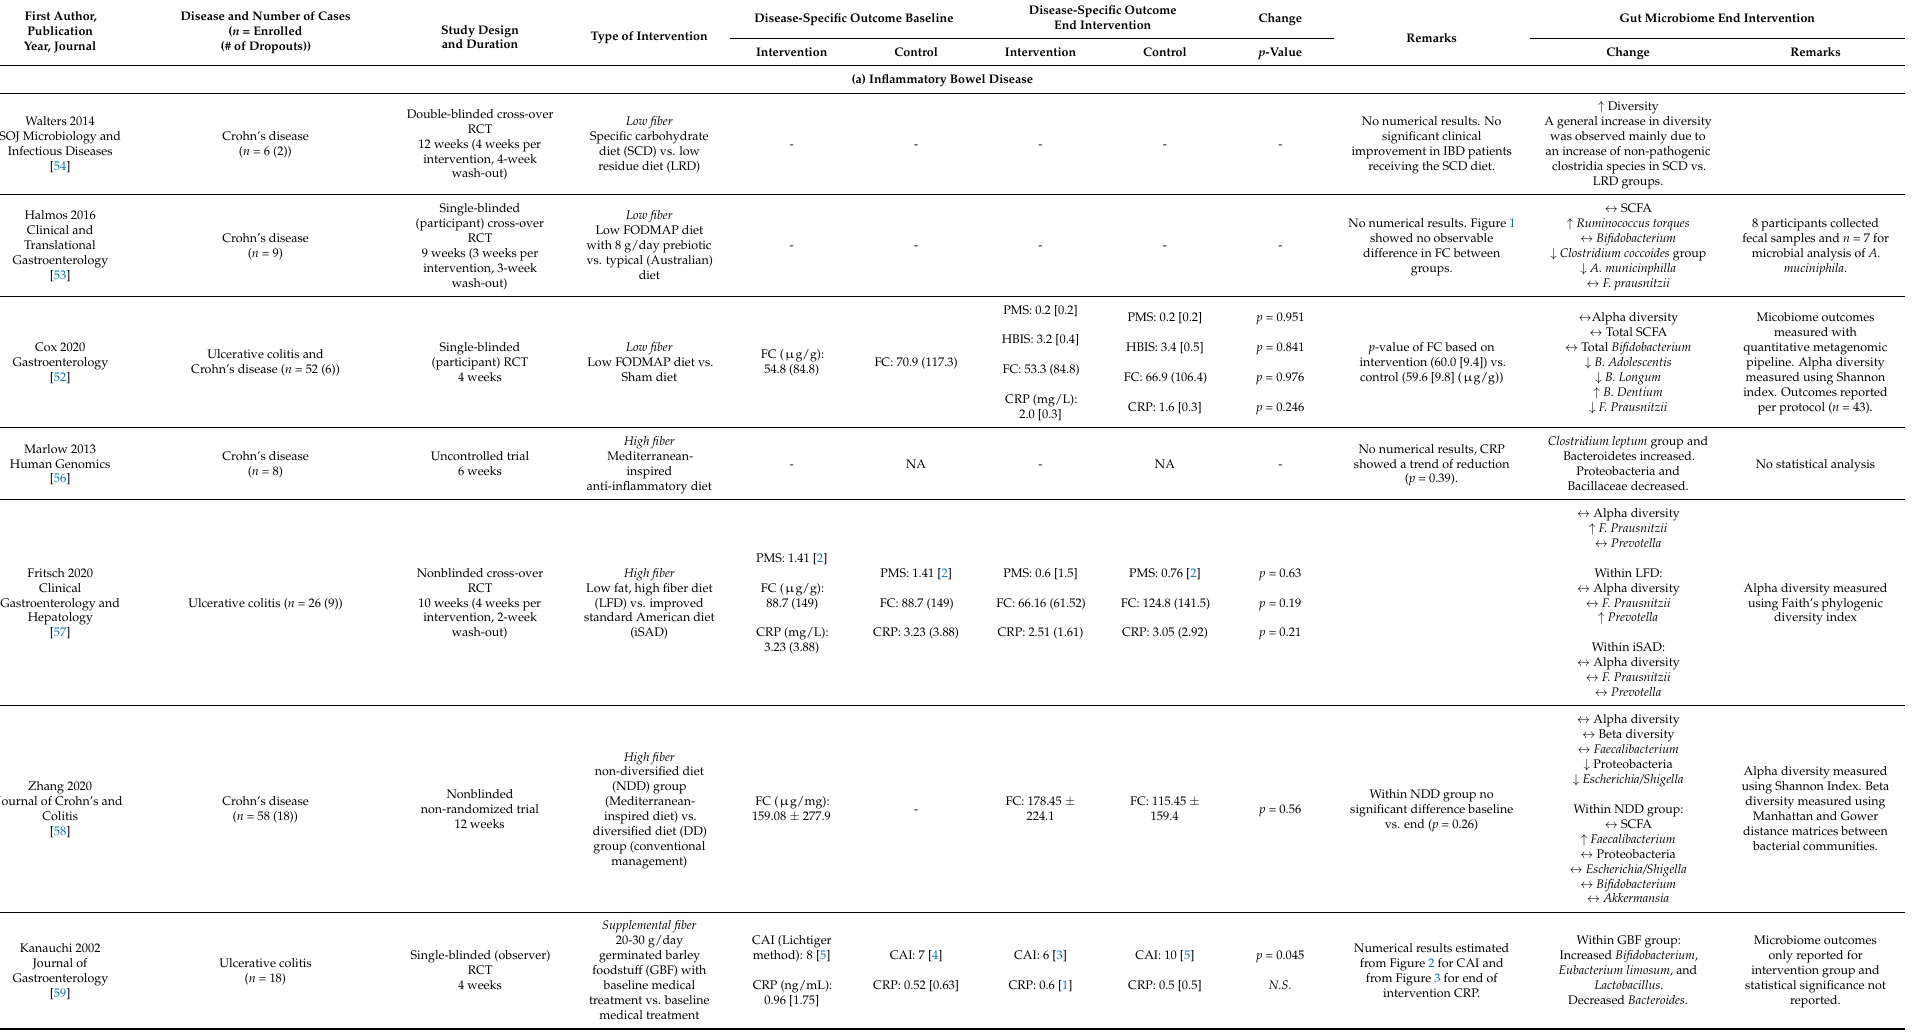
Table 1. Characteristics of the included studies and overview of outcomes in patients with: (a) inflammatory bowel disease, (b) rheumatoid arthritis, (c) cardiovascular disease, (d) type 2 diabetes. FirstAuthor, Publication Year,Journal